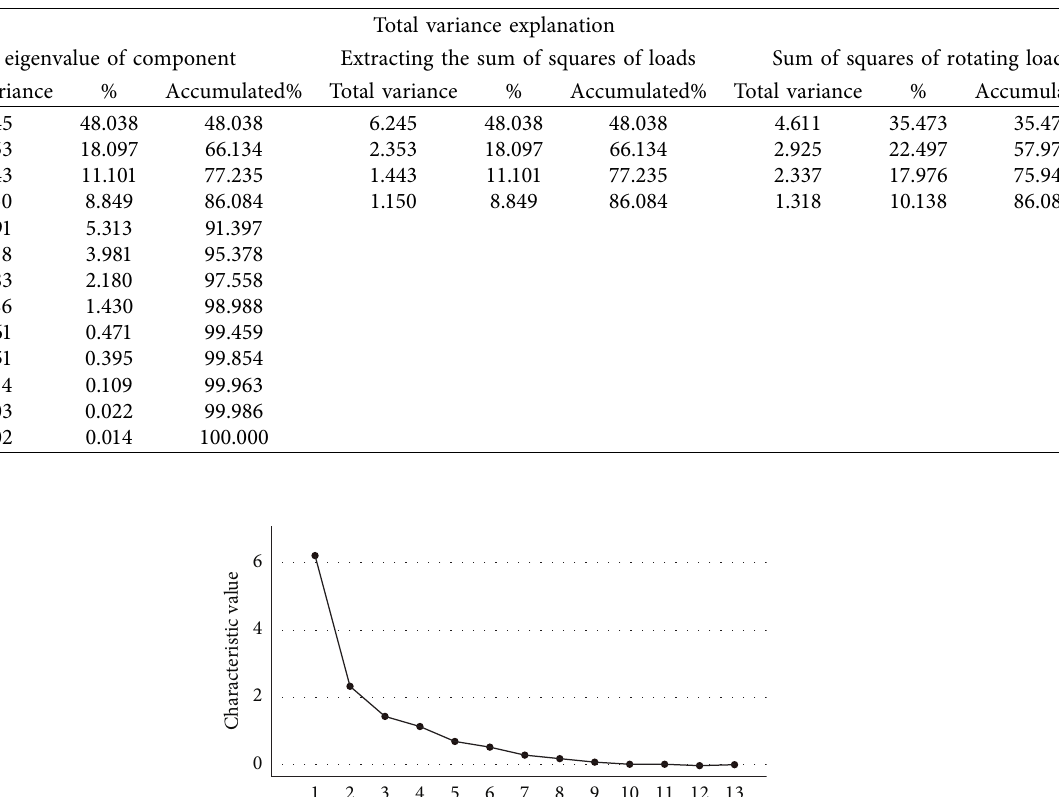
Table 5: Explanation of total variance of incense burners in the Qing Dynasty.